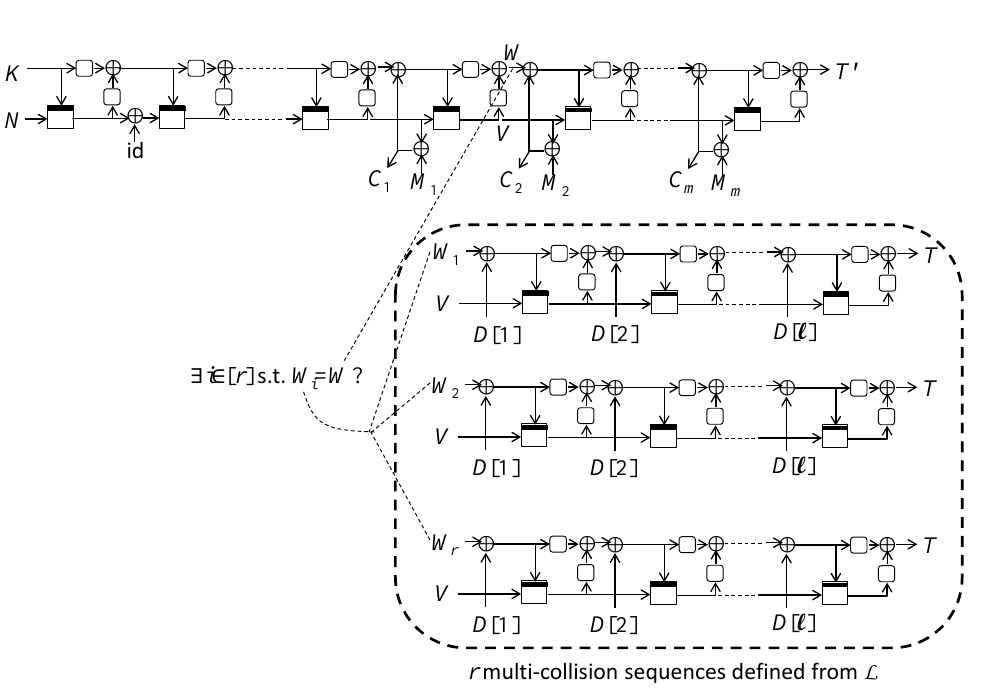
Figure 3: Multi-Collision